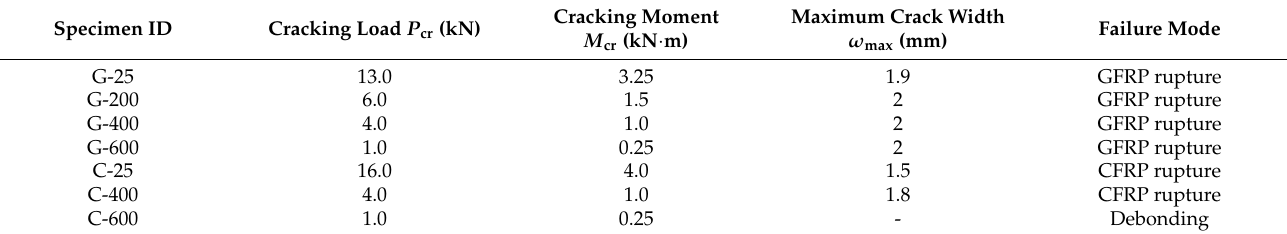
Table 3. Static test results of tested concrete beams.